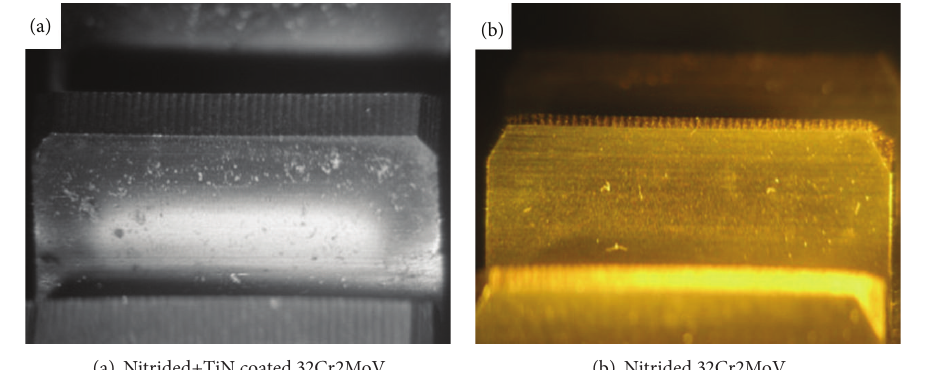
Figure 2: Tooth surface before gear rig contact